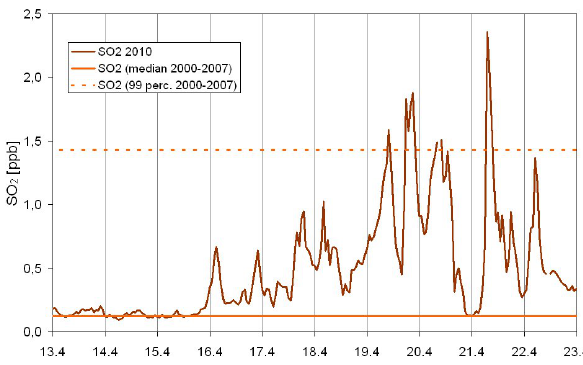
Fig. 4. SO 2 mixing ratio measured at the GAW Global Station Zugspitze/Hohenpeissenberg, platform HPB at 980m elevation. The continuous and dashed red lines indicate the median and the 99-percentile values of the SO 2 mixing ratios at